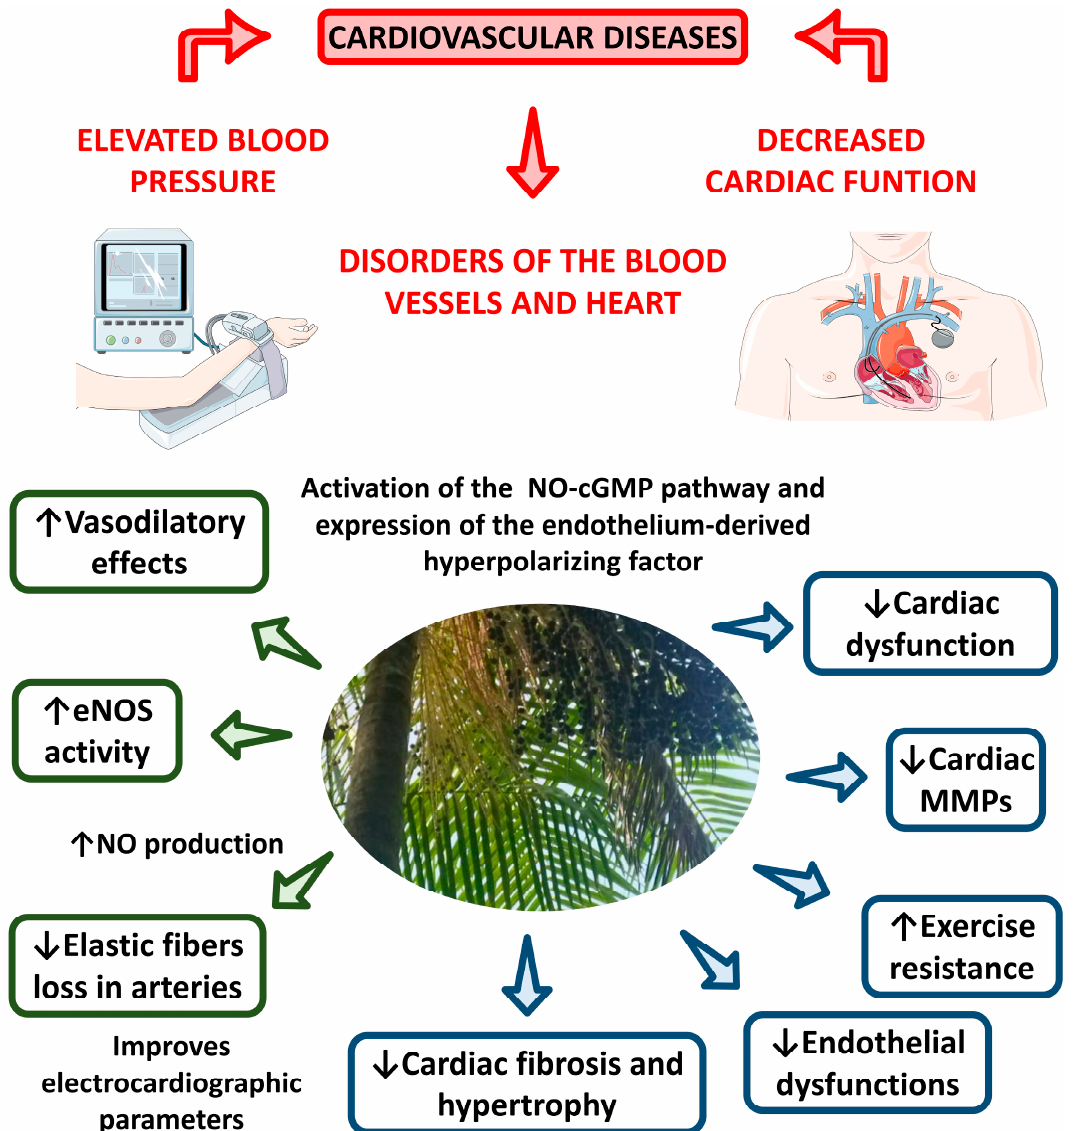
Figure 11. Potential actions of açaí against CVD and cardiovascular risk factors. Açaí improves cardiac function and decreases cardiac fibrosis, exerts vasodilatory effects, diminishes endothelial dysfunction, and ameliorates exercise resistance. Symbols and abbreviations: ↑ : increase; ↓ : decrease; eNOS: endothelial nitric oxide synthase; MMP: matrix metalloproteinase; NO: nitric oxide; NO–cGMP: nitric oxide cyclic guanosine monophosphate.